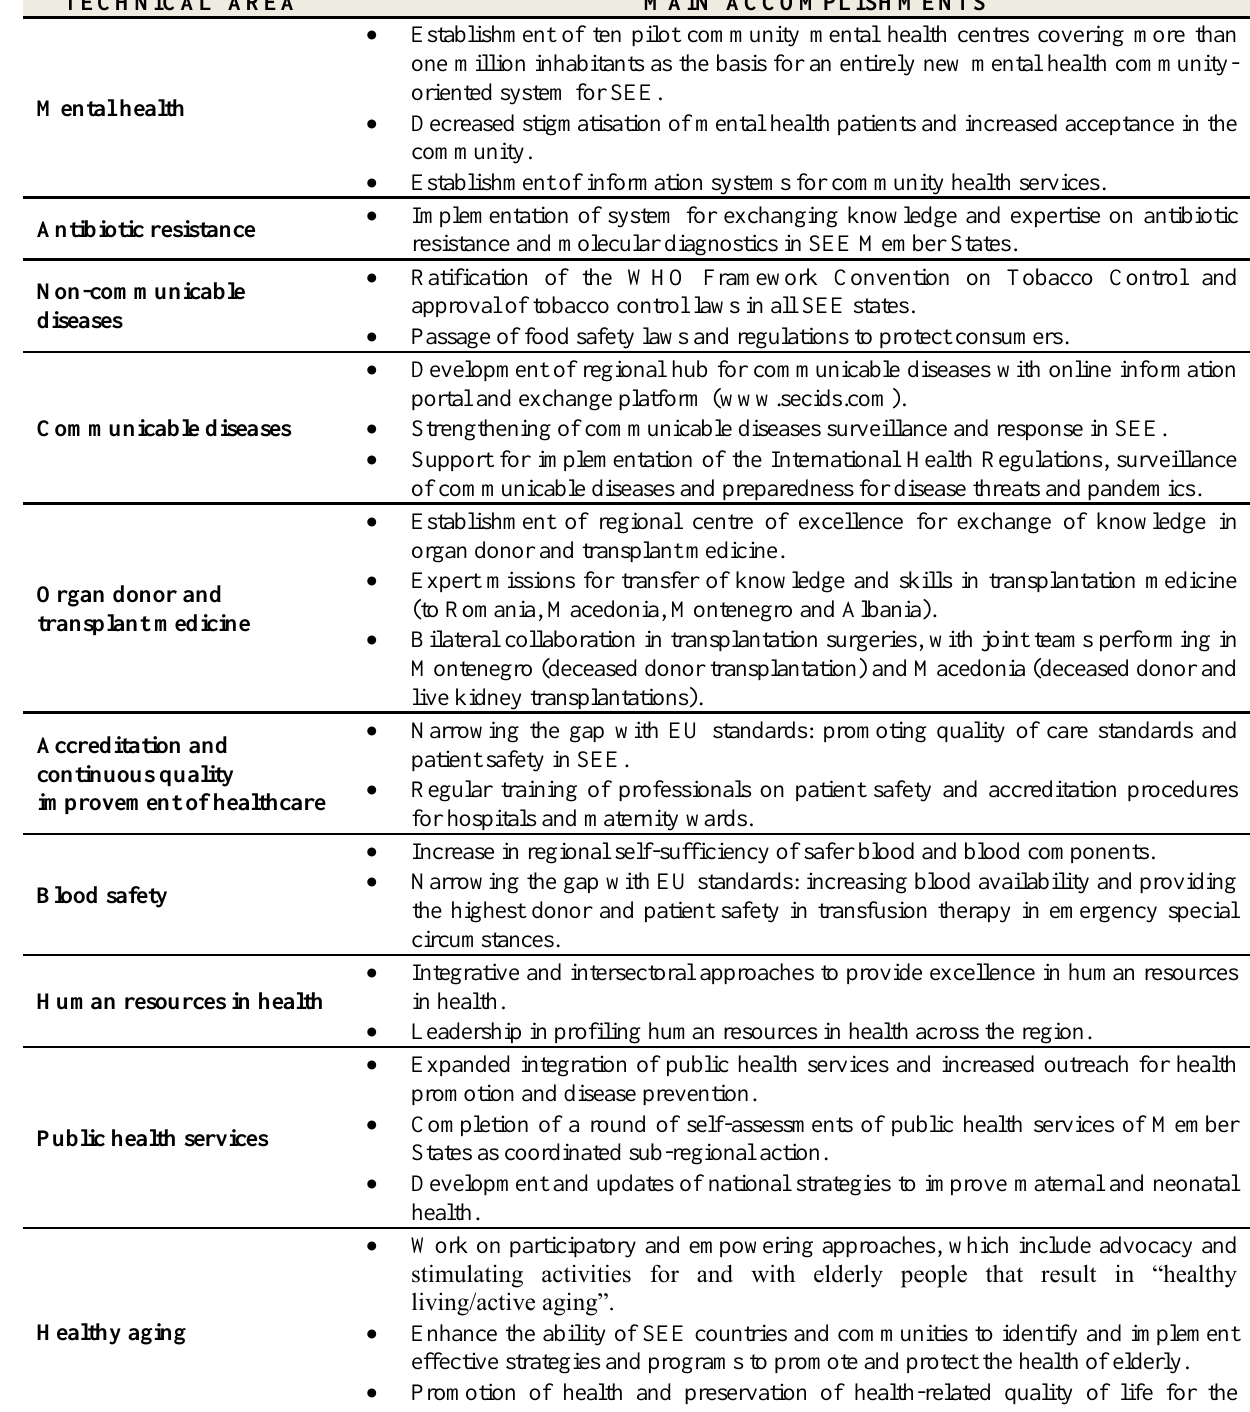
Table 1. Main accomplishments of the South Eastern Europe Health Network TECHNICAL